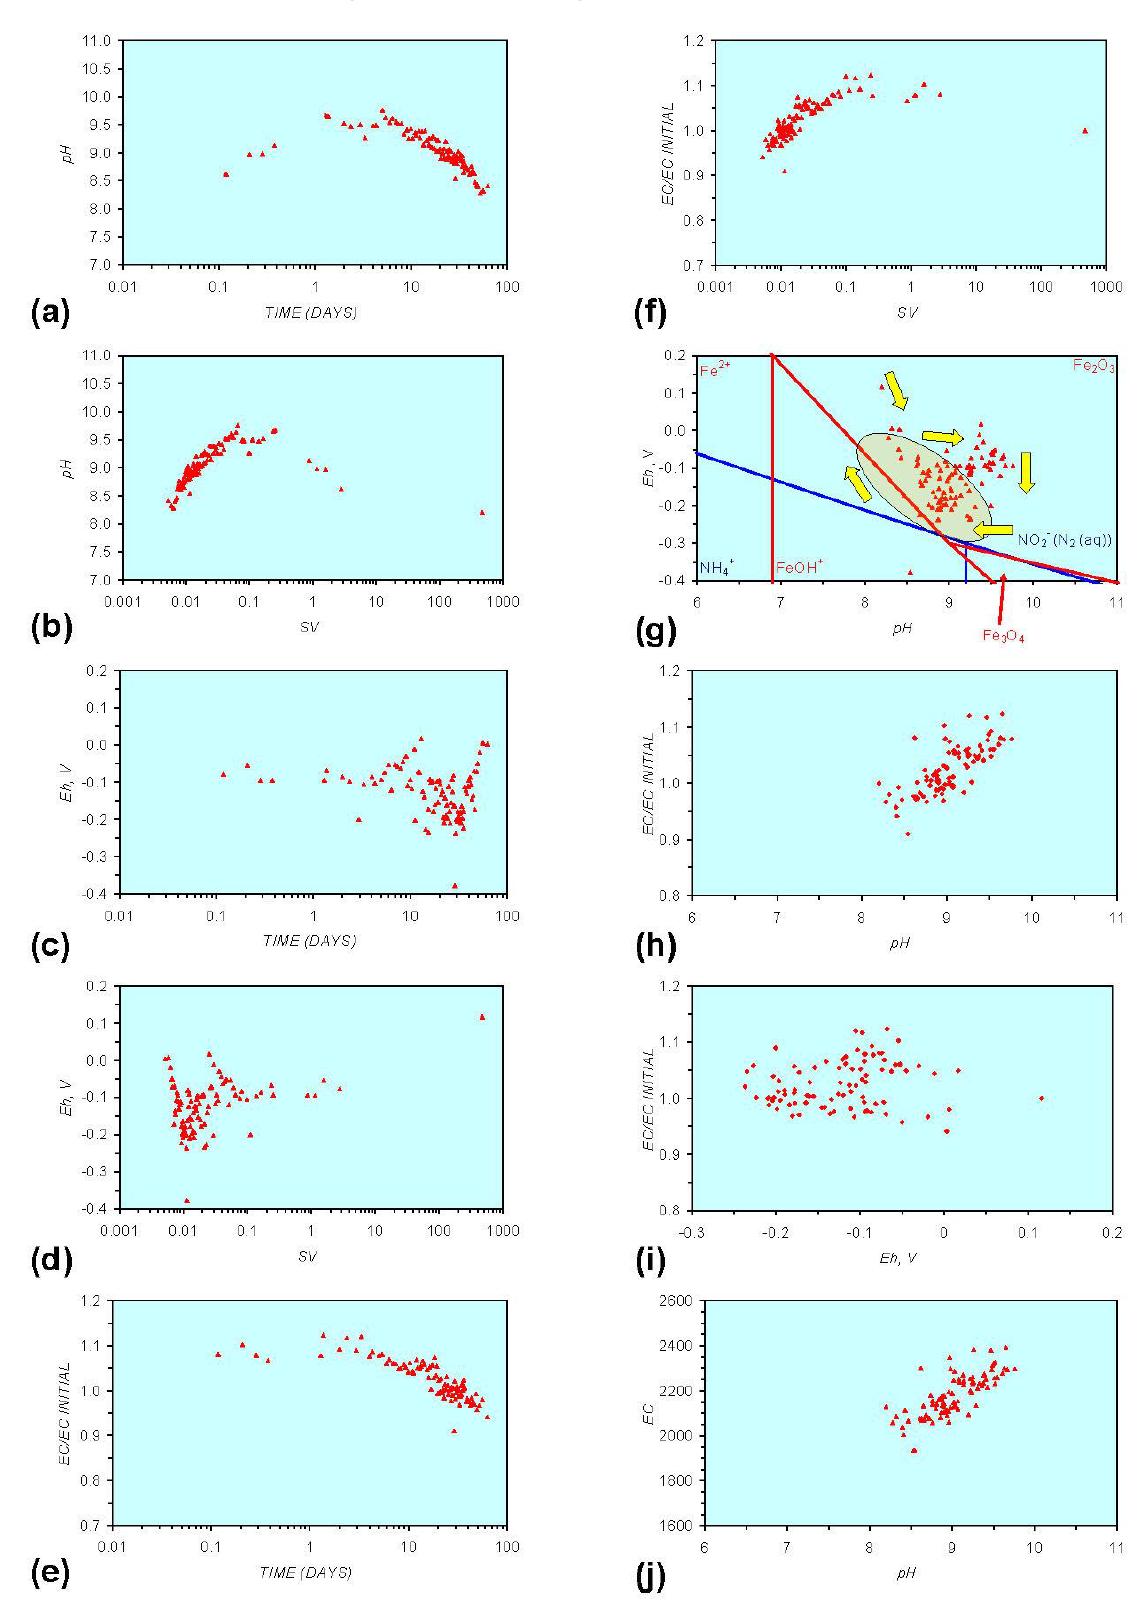
Figure A8. MR8: n-Fe 0 + n-Cu 0 + n-Al 0 , saline water. (a) pH vs. Time; (b) pH vs. SV; (c) Eh vs. time; (d) Eh vs. SV; (e) EC/EC Initial vs. time; (f) EC/EC Initial vs. SV; (g) Eh vs. pH (SRE ringed); (h) pH vs. EC/EC Initial; (i) Eh vs. EC/EC Initial; (j) pH vs. E(C) Arrows indicate decreasing SV and increasing